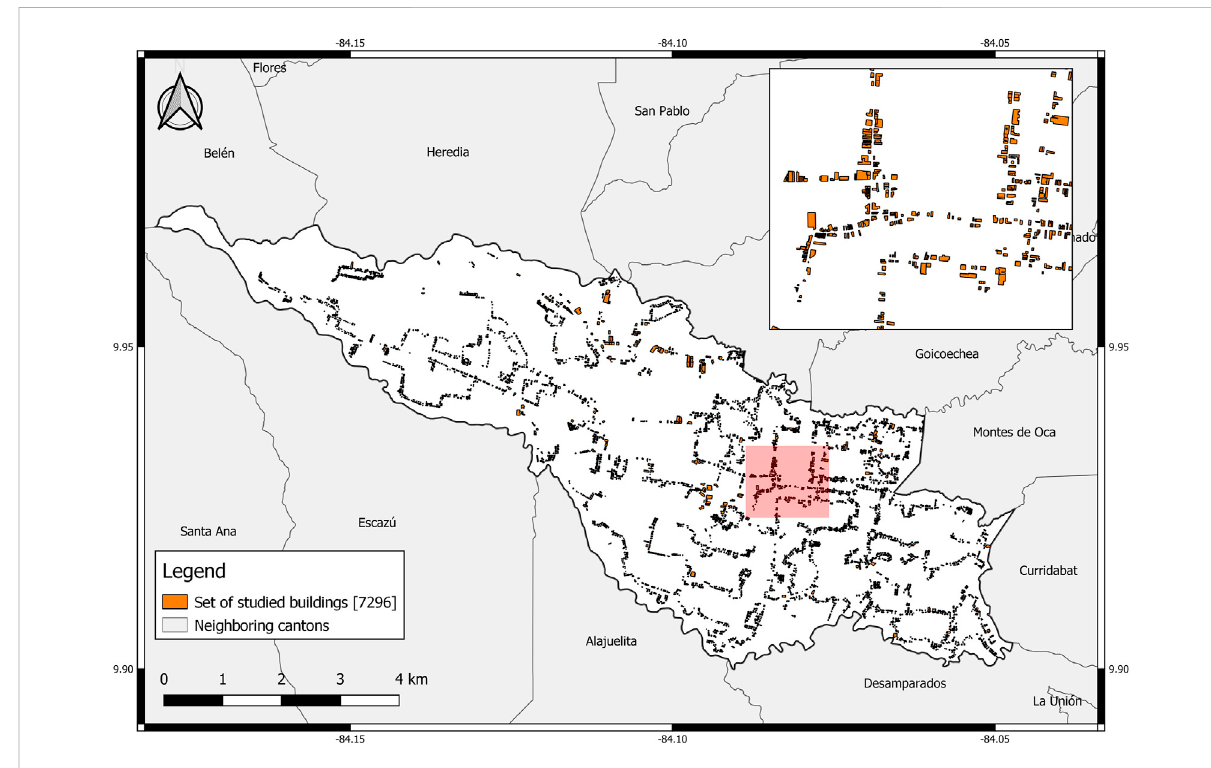
FIGURE 1 Location of the set of studied buildings. Each polygon corresponds to the footprint of a building.